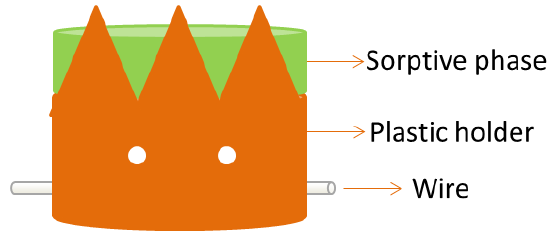
Figure 9. Device for stir cake sorptive extraction. Reproduced with permission of the Microextraction Tech blog.